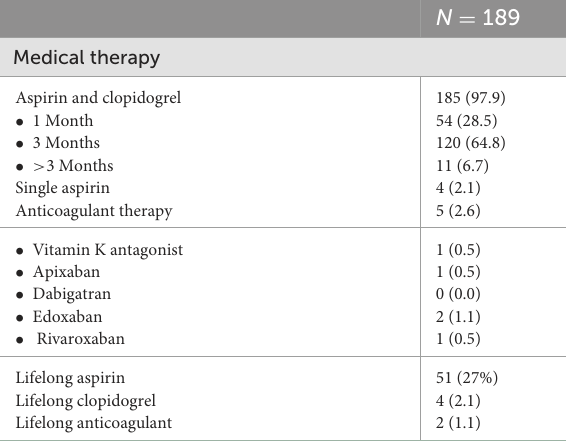
TABLE 2 Procedural characteristics. TABLE 3 Discharge medical